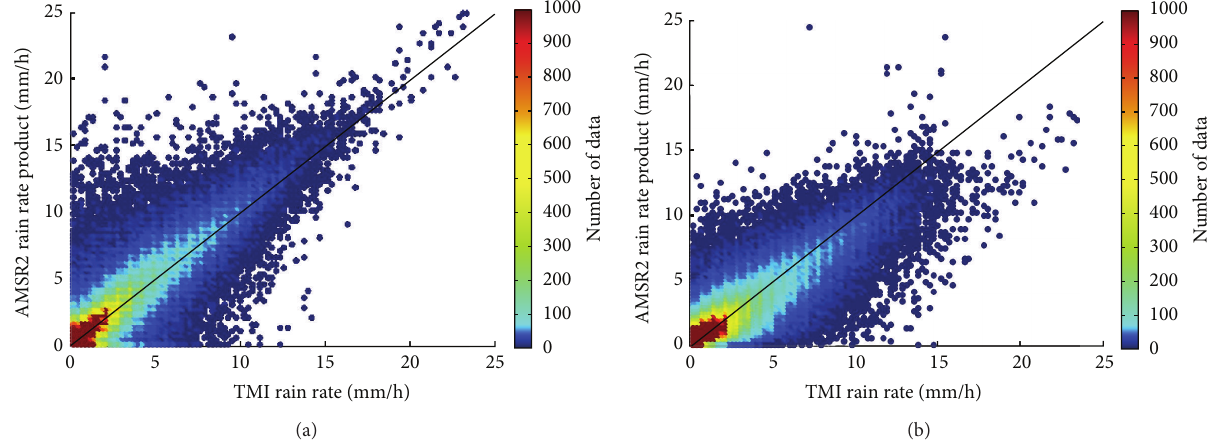
Figure 10: Scatter plot of AMSR2 rain rates versus TMI RSS rain rates for the period of August 2012–April 2014. Time collocation is within 10 minutes: (a) Remote Sensing Systems AMSR2 rain rate product and (b) rain rates, derived from AMSR2 Level 1B brightness temperatures with the new